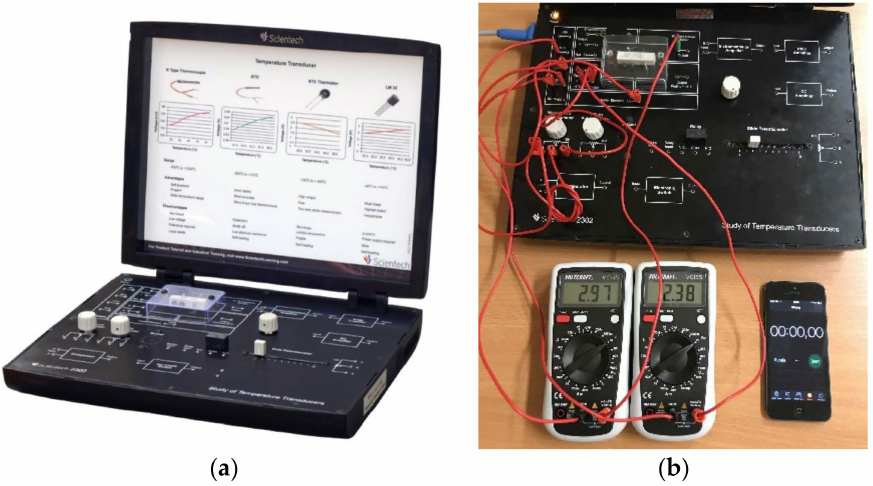
Figure 2. Measurement system to study temperature transducers: ( a ) measurement setup for test- ing temperature sensors; ( b ) connection of the system to study the negative temperature coefficient (NTC) sensor.